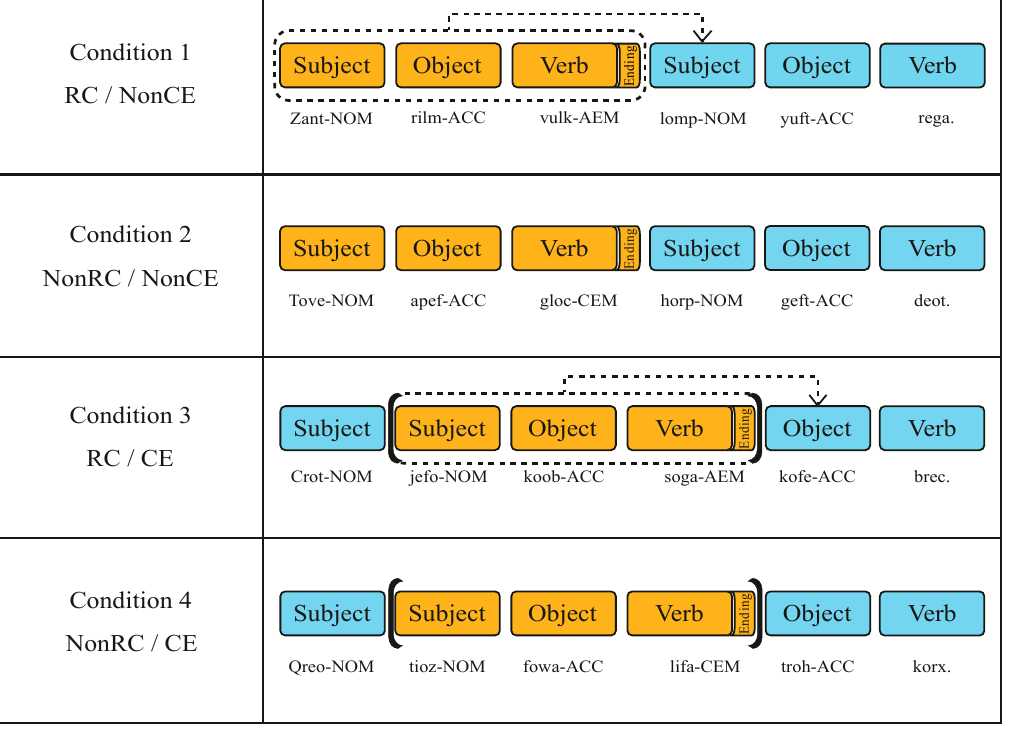
Figure 3. The pseudoword version of stimuli in Experiment 2. Blue and orange shades represent the main clause and the subordinate clause, respectively. Ending markers (an AEM or a CEM) are shown as “Ending” only after the first verb for easy explanation here. Case markers attached to each subject, object, and verb were shown throughout the actual experiment. Dotted arrows indicate the RC. Brackets surrounding the subordinate clause indicate the CE. Construction of every condition was identical to that of Figure 2. Pseudowords did not provide participants with cues for a constituent—whether the word was a noun or a verb. Therefore, they could only infer the syntactic role of the pseudowords by case markers or ending markers attached to the pseudowords. Here we have provided English pseudowords with four letters to aid understanding of the stimuli. In the actual experiment, we used Korean two-syllable pseudowords. Abbreviations: RC (relative clause), CE (center embedding), AEM (adnominalizing ending marker), CEM (conjunctive ending marker), NOM (nominative case marker), ACC (accusative case